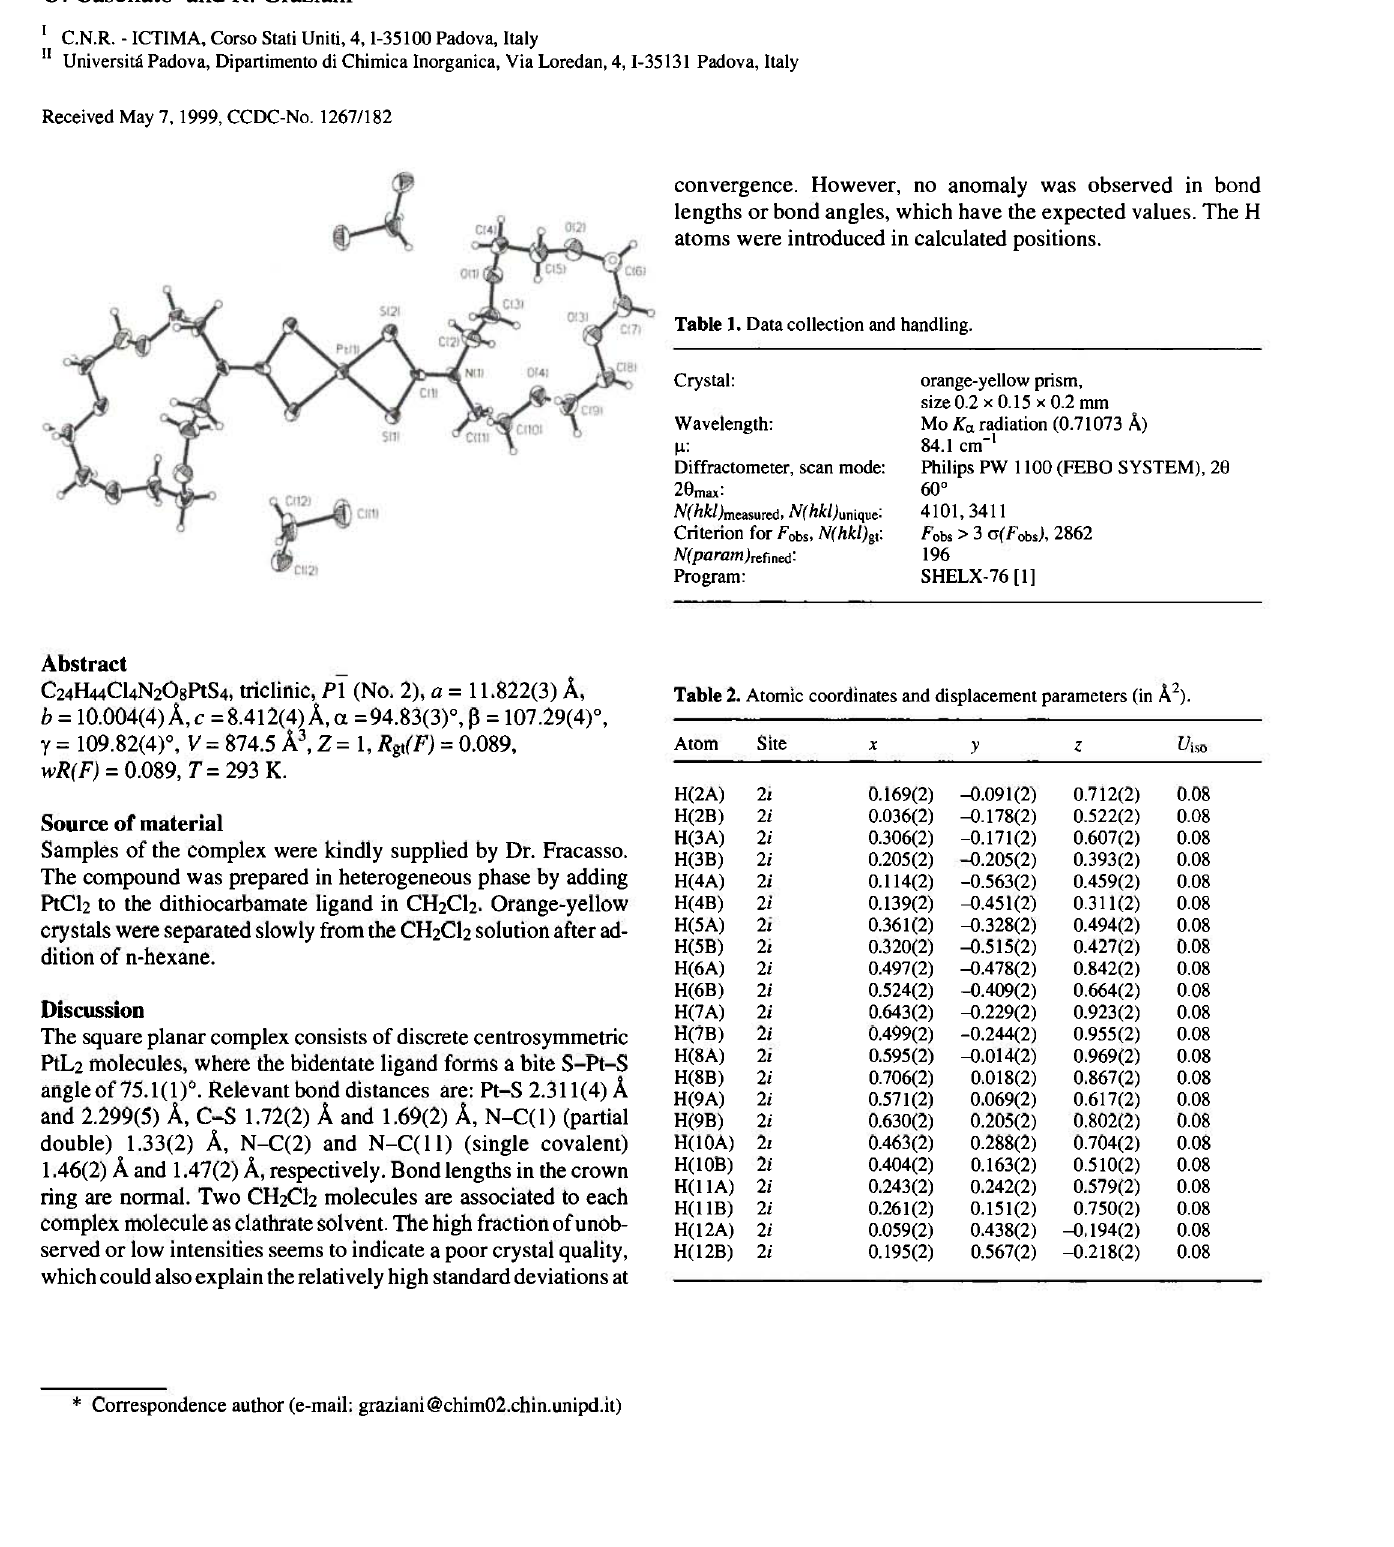
Table 1. Data collection and handling.